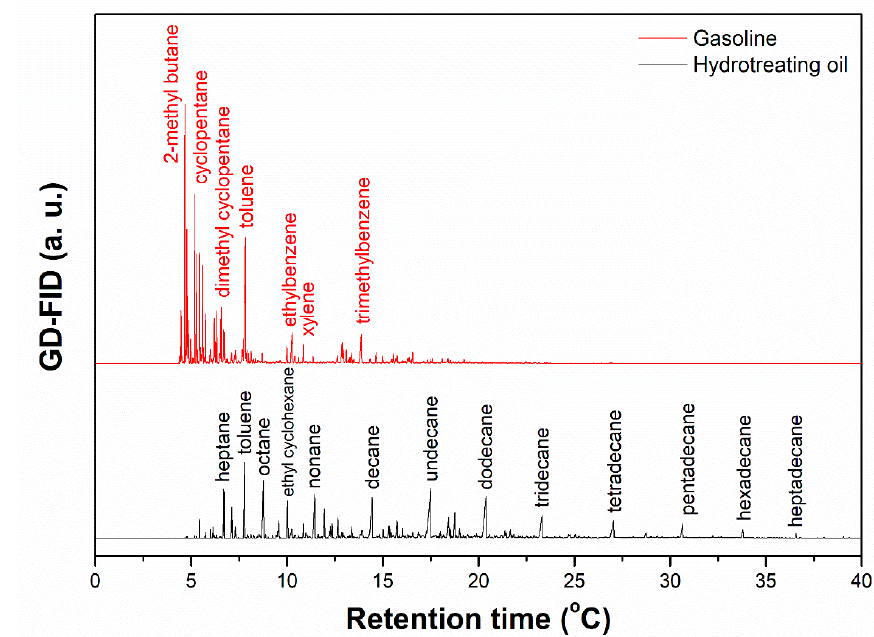
Figure 4. GC-FID profiles of gasoline and hydrotreating oil, which is produced by deep hydrotreating of light distillates over sulfide CoMo/ γ -Al 2 O 3 catalyst at 350 °C and 7 MPa of H 2 for 5 h.